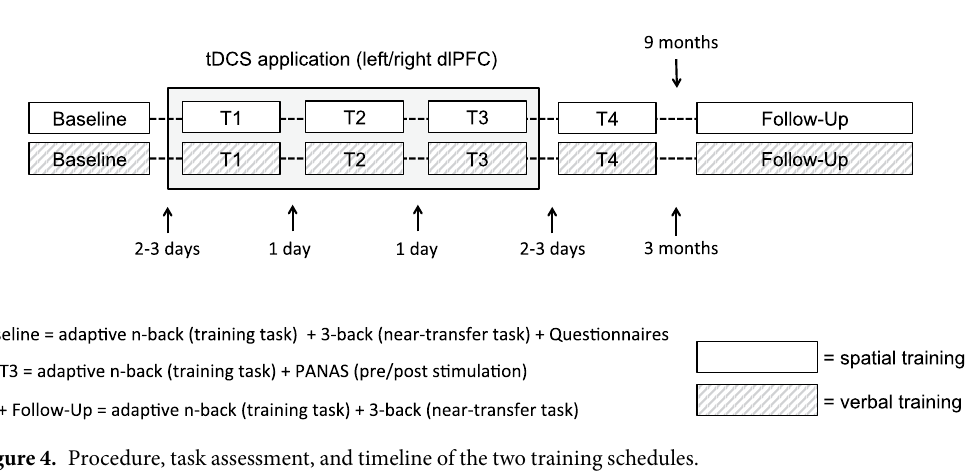
Figure 4. Procedure, task assessment, and timeline of the two training